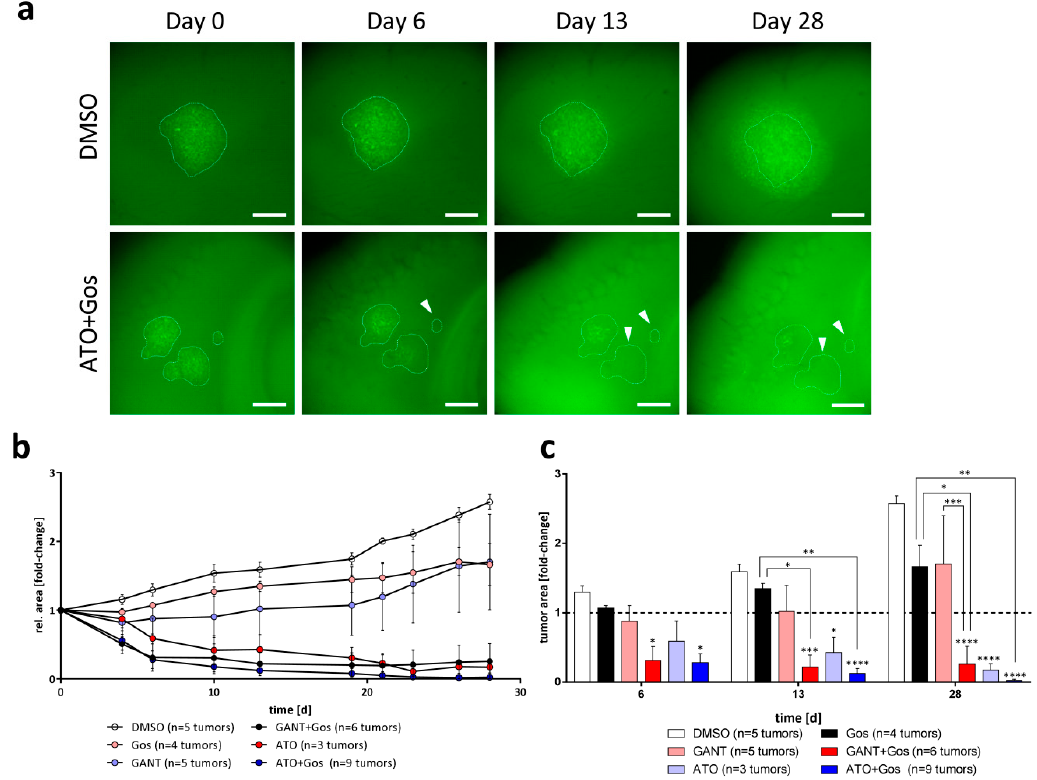
Figure 6. ATO, ATO/Gos and GANT/Gos decrease tumor size in adult OTC